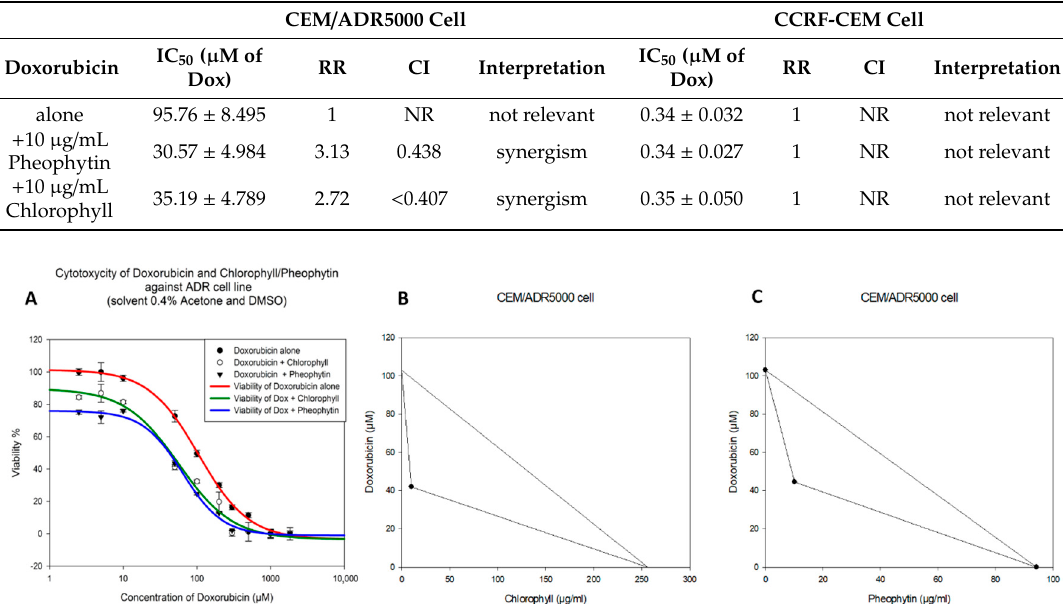
Table 2. The cytotoxicity of doxorubicin against CEM/ADR cells and CCRF-CEM, either alone or in combination with chlorophyll or pheophytin. Data were obtained from at least three independent experiments and are represented as mean ± SD. Combination index (CI) 0.1–0.3: strong synergism and